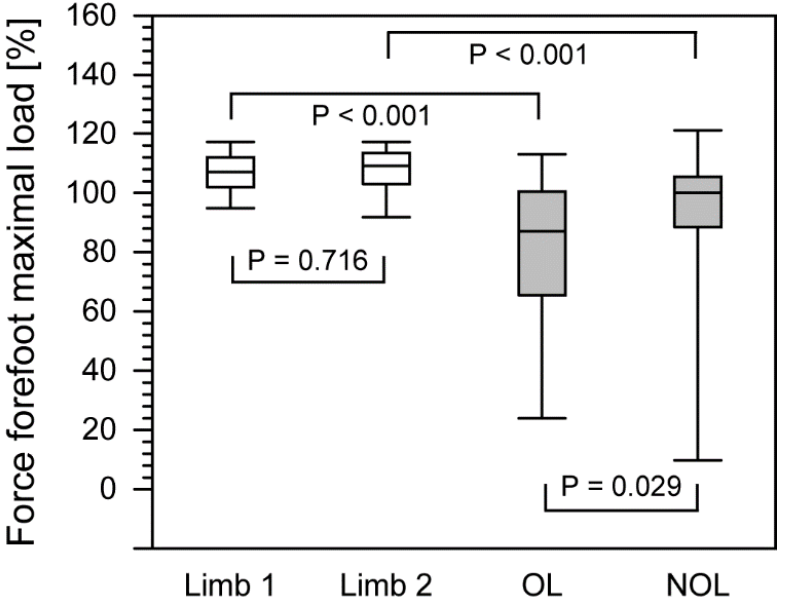
Figure 2. The comparison of force forefoot maximal load between healthy group and patients after treatment with the Ilizarov method. The boundary of the box closest to zero indicates the 25th percentile, a line within the box marks the median, and the boundary of the box farthest from zero indicates the 75th percentile. Whiskers above and below the box indicate the 90th and 10th percentiles. White boxes, healthy people; filled boxes, patients. OL, operated limb; NOL, non-operated limb.